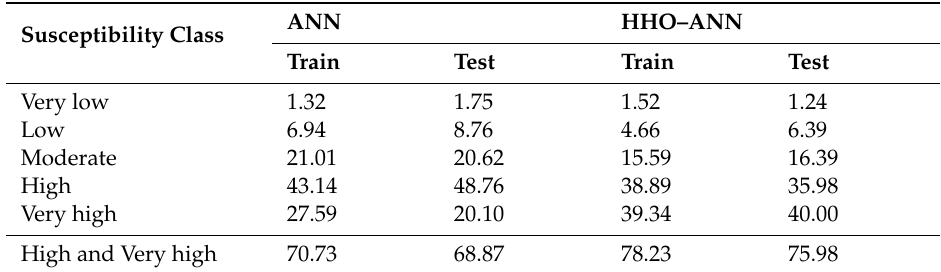
Table 4. The percentage of the training and testing landslides located in each susceptibility